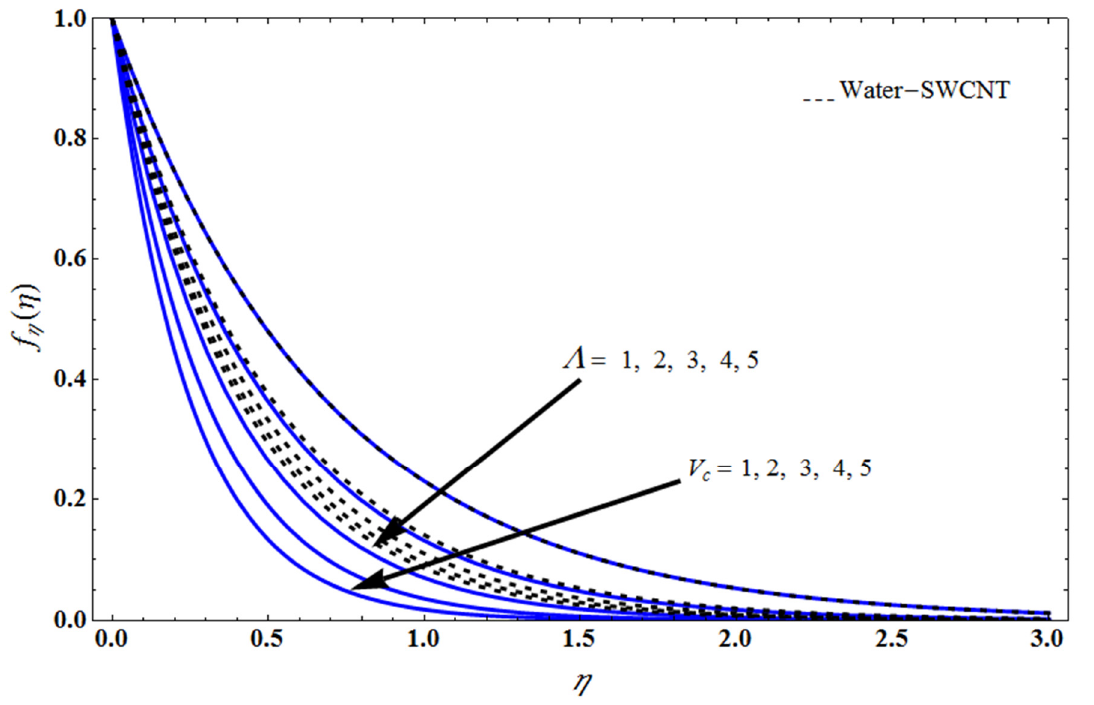
Figure 5. Effect of Axial velocity f η ( η ) versus similarity variable η for various values of mass transpiration V c , and Λ ,